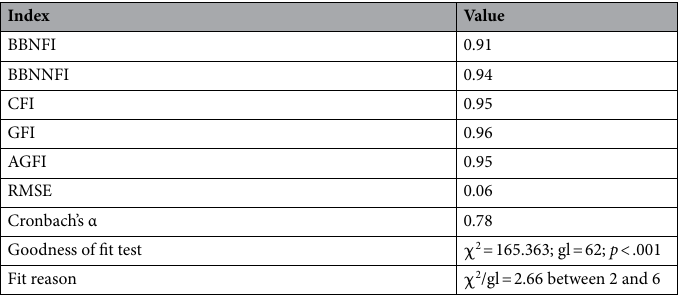
Table 3. Goodness of fit indices of model confirmatory. BBNFI Bentler–Bonett normed fit index, BBNNFI Bentler–Bonett non normed fit index, CFI comparative fit index, GFI goodness of fit index, AGFI adjusted goodness of fit index, RMSE root mean standard error, Df degrees of freedom.